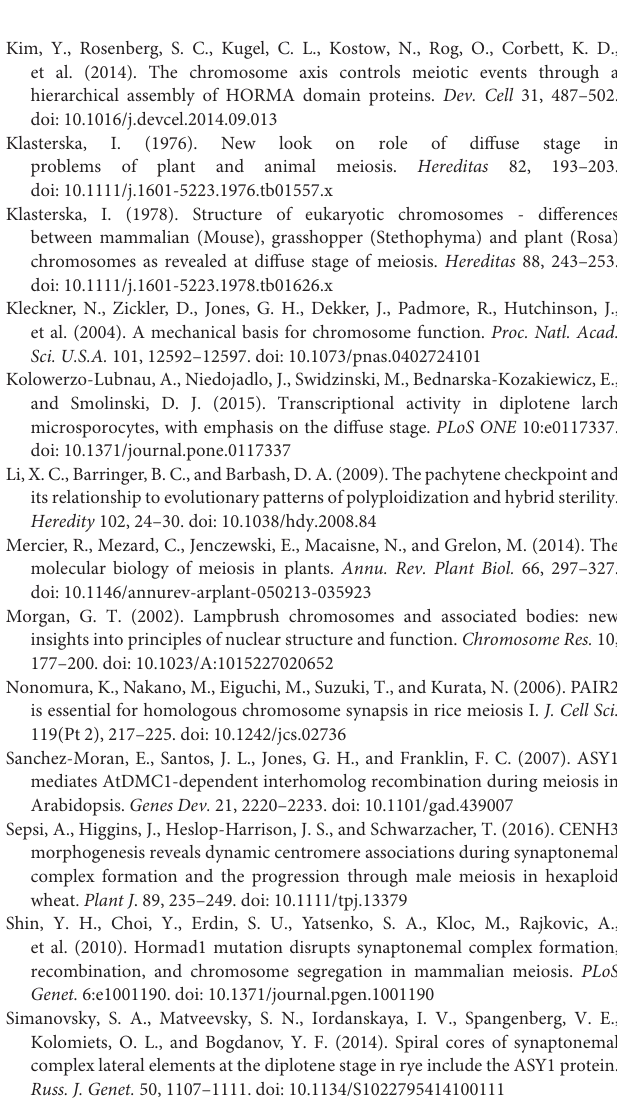
Supplementary Video 2 | 3D Barley Zygotene with ZYP1 (magenta) and ASY1 (green). Supplementary Video 3 | 3D Wheat Zygotene with ZYP1 (magenta) and ASY1 (green). Supplementary Video 4 | 3D Barley Pachytene with ZYP1 (magenta) and ASY1